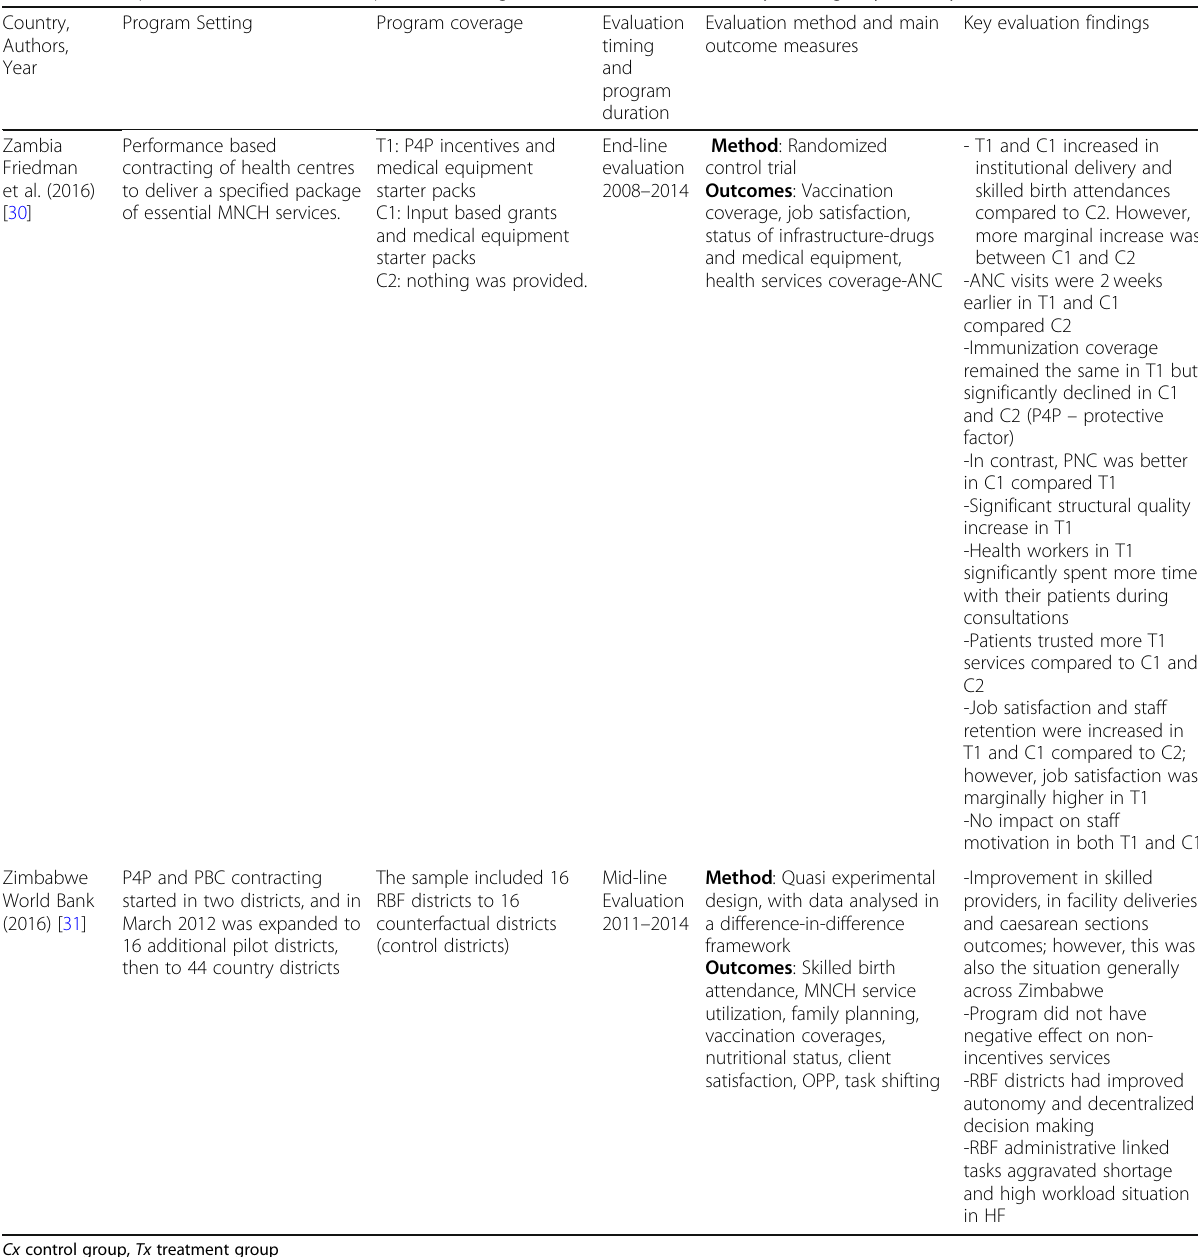
Table 1 Description of RBF evaluation reports including evaluation methods and key findings, by country